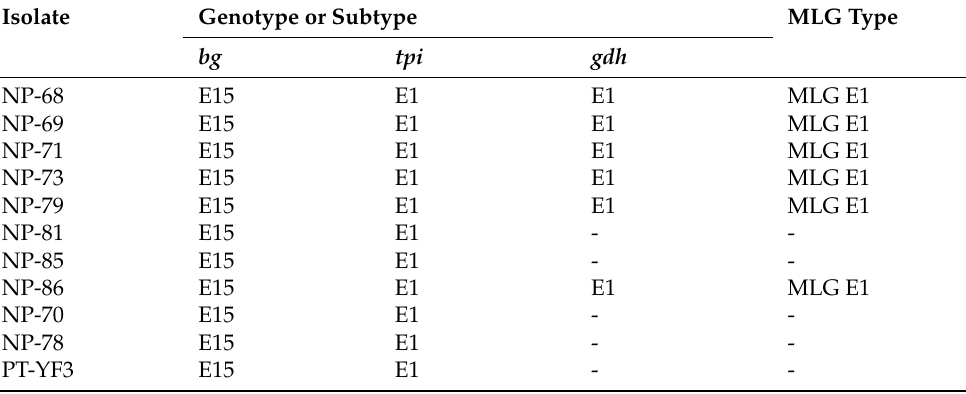
Table 2. Multilocus characterization of G. duodenalis isolates based on bg , tpi and gdh